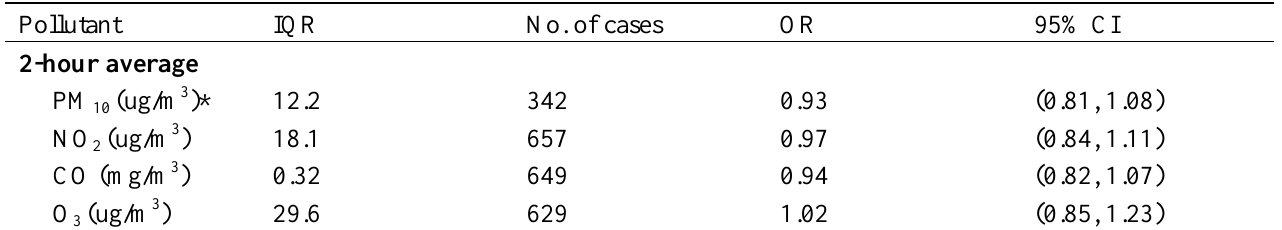
Table 3. Association of air pollutants with onset of myocardial infarction. Estimated odds ratios (OR) are adjusted for temperature and relative